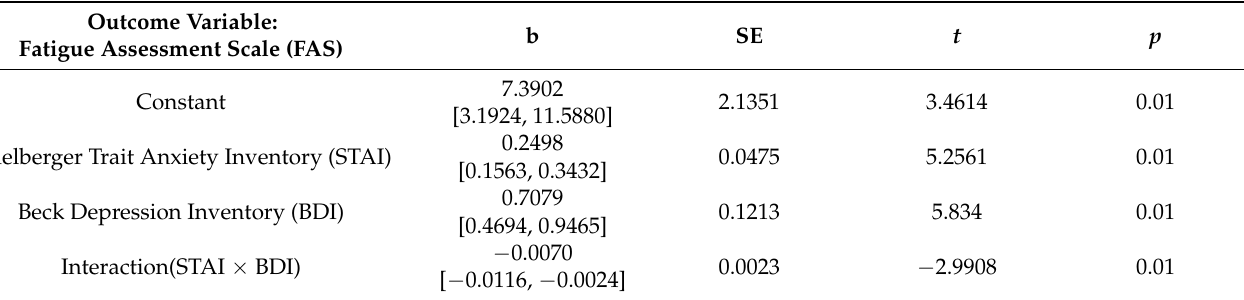
Table 5. Moderation analysis: Beck Depression Inventory (BDI) as a moderator of the relation- ship between Spielberger Trait Anxiety Inventory (STAI) and Fatigue Assessment Scale (FAS) with Spielberger State Anxiety as a mediator